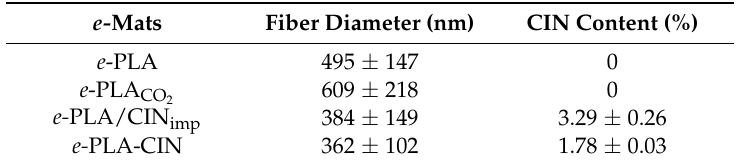
Table 1. Fiber diameter of electrospun poly lactic acid ( e- PLA) mats and cinnamaldehyde (CIN) content of active